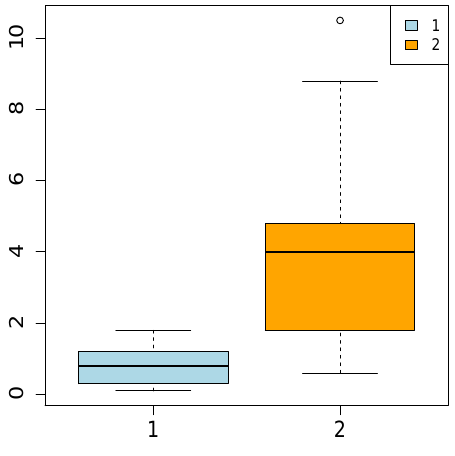
Figure 3. Boxplot of the variable “ CO 2 ” in clusters 1 and